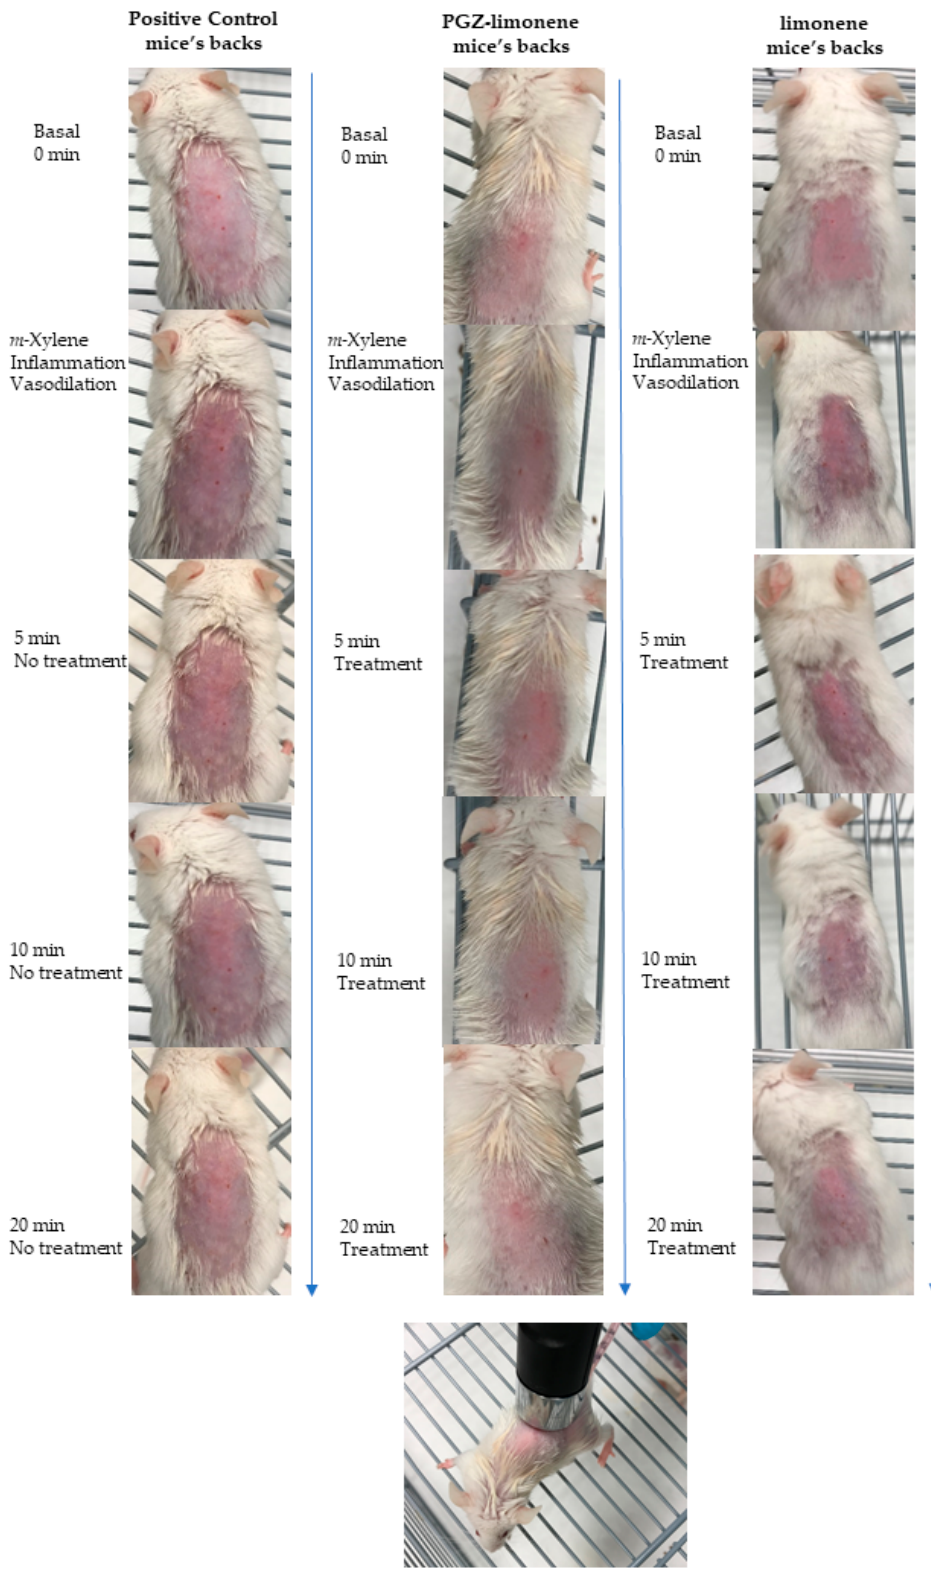
Figure 3. Evolution of erythema shown as skin color sequence on mice’s backs, using PGZ-limonene and limonene compared with positive control. Colors are reproduced from the average values of three basic light components, red, green, and blue (RGB) codes using a Multi Probe Adapter (MPA) 5 Multi Probe adapter from Courage + Khazaka electronic GmbH (Cologne, Germany), equipped with a CL400.